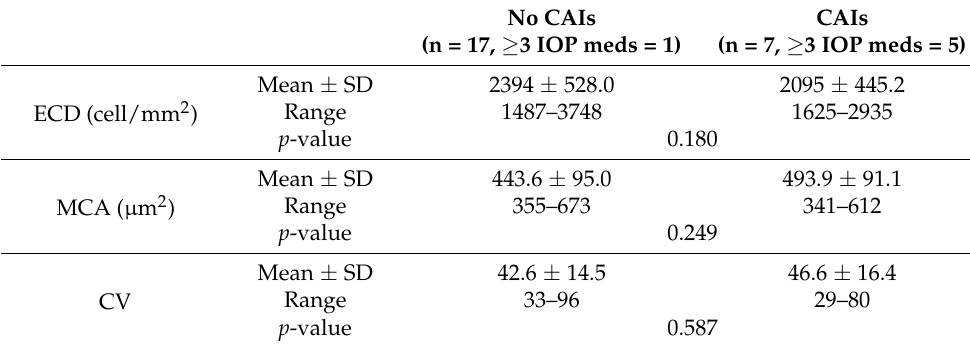
Table 6. Usage of carbonic anhydrase inhibitors within NTG